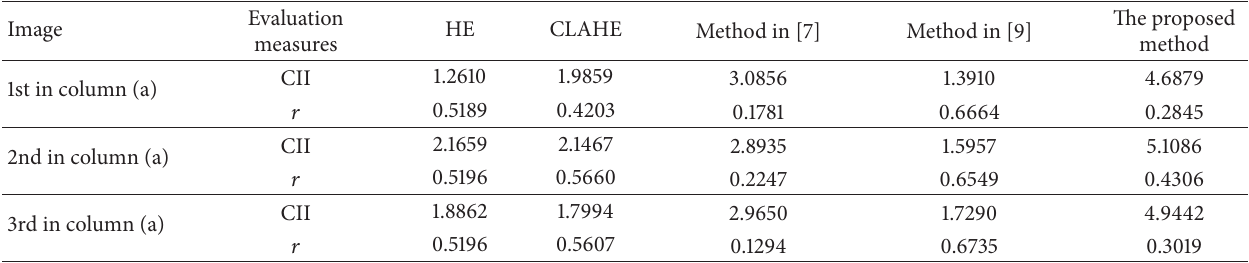
Table 3: The comparison of CII and r with different methods on images shown in Figure